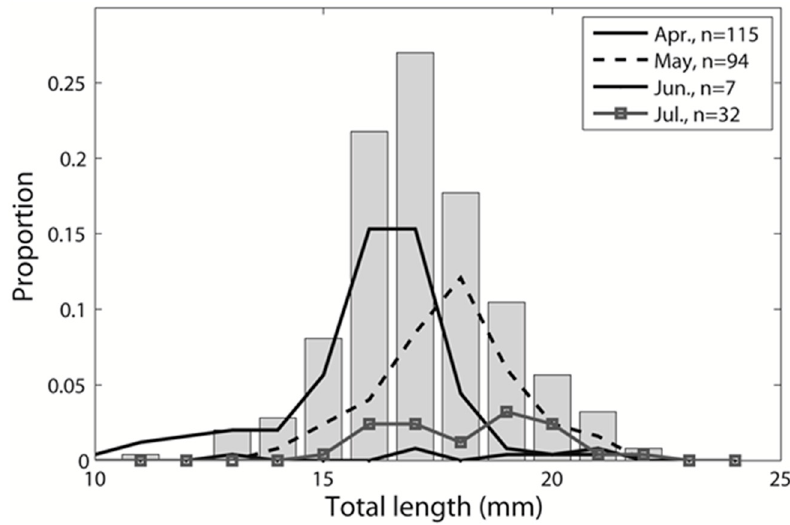
Figure 6. Length − frequency distributions of Euphausia pacifica adults in the East Sea. Gray bars represent the length − frequency distribution in four surveys. The lines indicate the length − frequency distribution from April to July 2010. Table 3. Mean (standard deviation, SD) and median (standard error, SE) of Euphausia pacifica density (g m − 2 ), integrated from 20 m to the bottom from April to July, 2010. The monthly densities were estimated from the 120-kHz S V data using multi-frequency analysis methods.